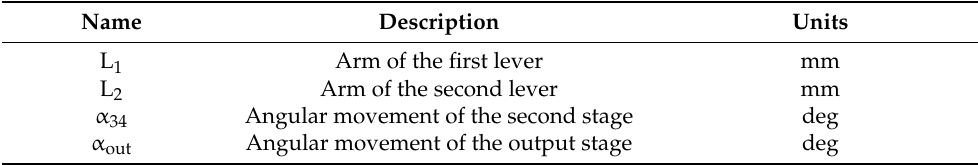
Table 4. Amplification mechanism equations results.